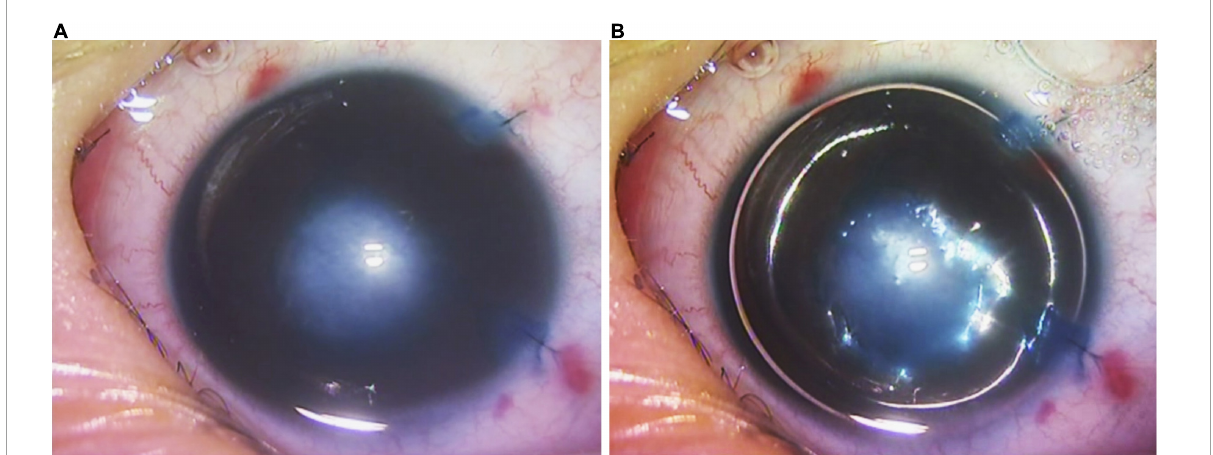
FIGURE1 Intra-operative video screenshots of patient 2’s right eye. (A) Selective endothelial removal resulted in the intentional creation of a central endothelial defect underlying the central corneal opacity, evidenced by positive staining with trypan blue. (B) Following trypan blue staining, a full intracameral air bubble was injected. The absence of a reflective ring around the central region of trypan blue staining indicated that the Descemet’s membrane was intact despite selective endothelial removal.